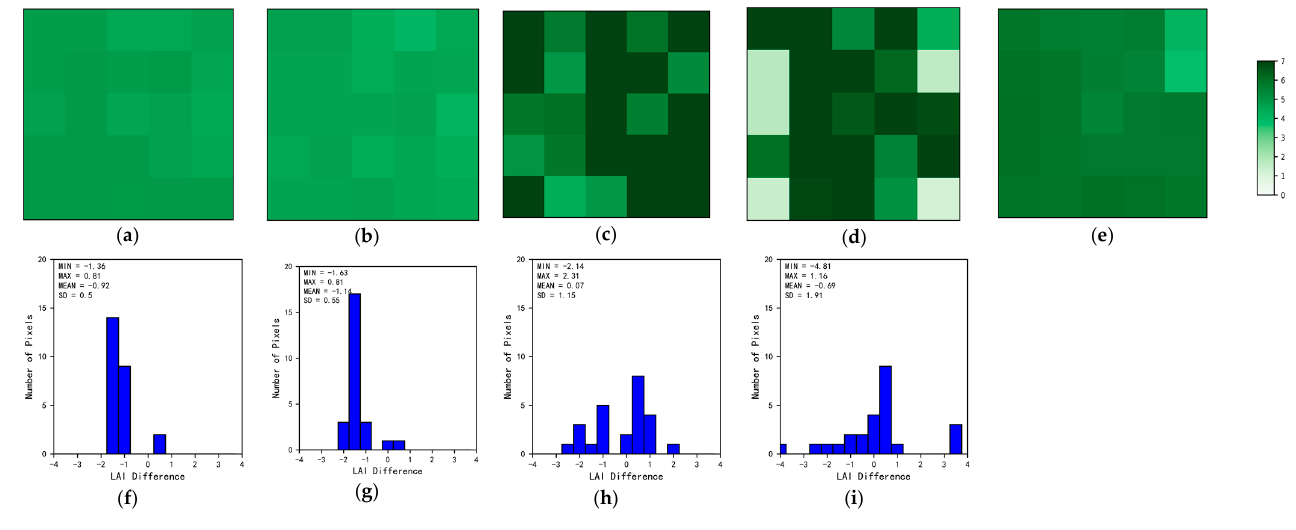
Figure 14. Images of the LAI-TCA ( a ), the LAI-GRNN ( b ), the VIIRS ( c ), the MODIS ( d ) and the LAI values acquired from high-resolution reference maps ( e ) at the Albufera site on Day 219, 2014. ( f–i ) Statistical distributions of discrepancies between the LAI-TCA, the LAI-GRNN, the VIIRS, the MODIS and the LAI values acquired from high-resolution reference maps.